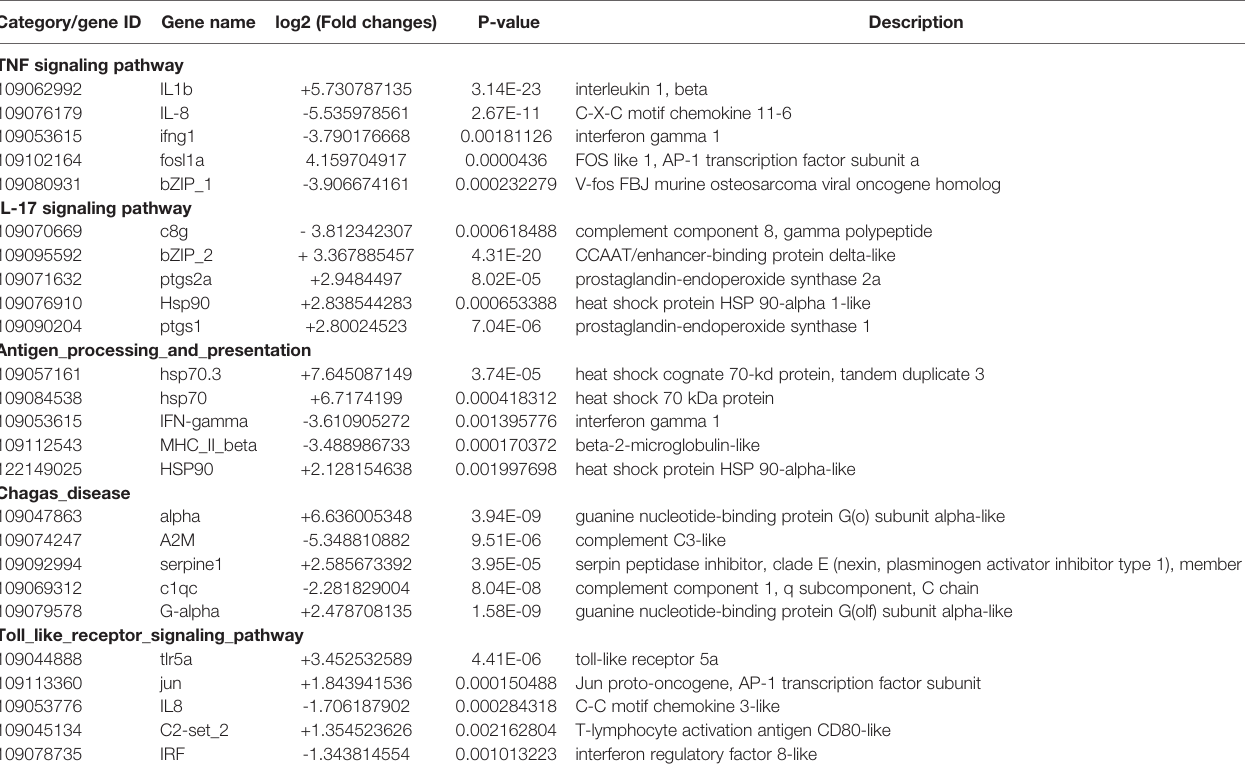
TABLE 3 | Immune-related differentially expressed following P. shigelloides challenge based on the KEGG analysis. Category/gene ID Gene name log2 (Fold